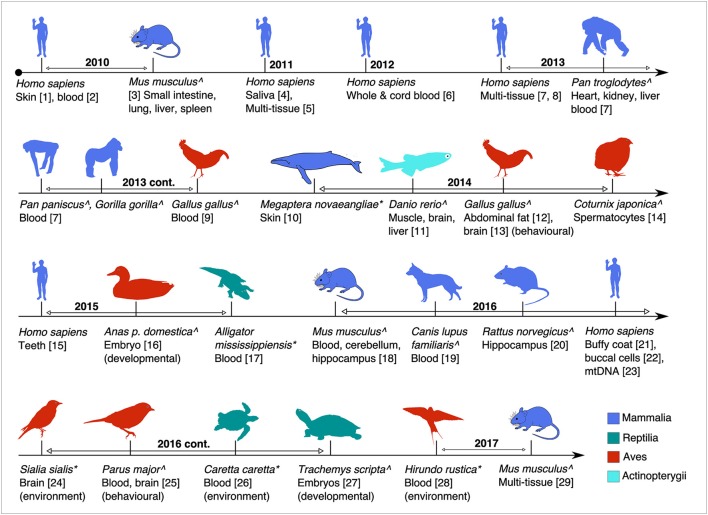
Timeline of the major studies and tissues analysed for global or targeted DNA methylation in this review. Studies are age-associated except where indicated. Superscripts: ∧(captive raised or model studies) and *(wild animal studies). (1, Grönniger et al., 2010; 2, Teschendorff et al., 2010; 3, Maegawa et al., 2010; 4, Bocklandt et al., 2011; 5, Koch and Wagner, 2011; 6, Garagnani et al., 2012; 7, Horvath, 2013; 8, Hannum et al., 2013; 9, Gryzinska et al., 2013; 10, Polanowski et al., 2014; 11, Shimoda et al., 2014; 12, Sun et al., 2014; 13, Nätt et al., 2014; 14, Andraszek et al., 2014; 15, Bekaert et al., 2015; 16, Yan et al., 2015; 17, Nilsen et al., 2016; 18, Spiers et al., 2016; 19, Gryzinska et al., 2016; 20, Penner et al., 2016; 21, Christiansen et al., 2016; 22, Eipel et al., 2016; 23, Mawlood et al., 2016; 24, Bentz et al., 2016; 25, Verhulst et al., 2016; 26, Caracappa et al., 2016; 27, Matsumoto et al., 2016; 28, Romano et al., 2017; 29, Stubbs et al., 2017).